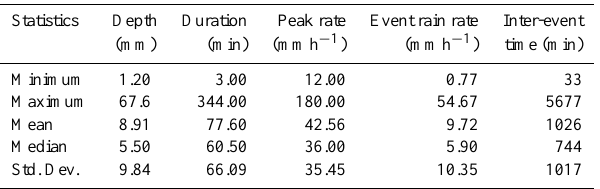
Table 1. Statistics of rain events at Jema in two wet seasons that are JJA of the years 2007 and 2008.